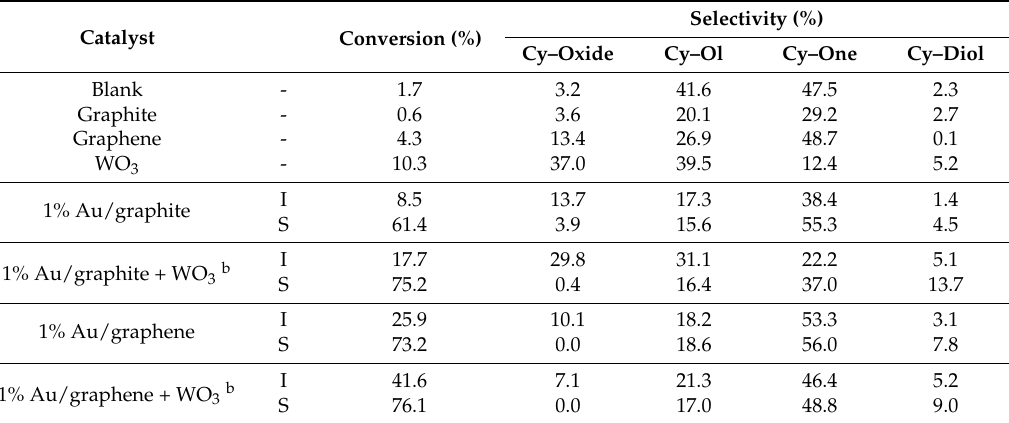
Table 1. Performance of catalysts in cyclohexene oxidation a .